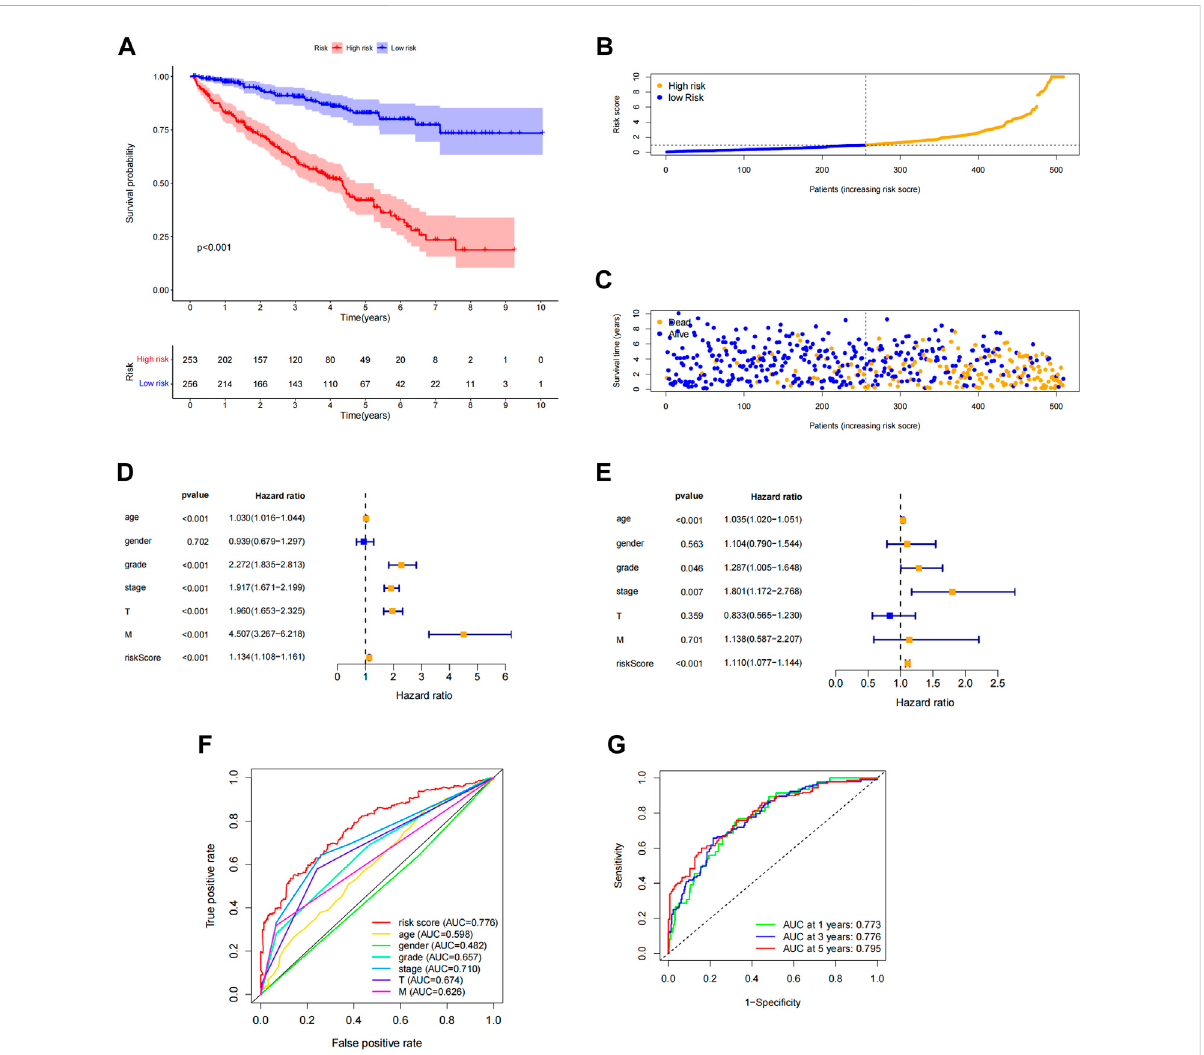
FIGURE 4 Association of predictive features with prognosis in ccRCC patients. (A) Kaplan-Meier analysis of OS rates in the high- and low-risk groups of ccRCC patients. (B) Distribution of risk scores in ccRCC patients. (C) Number of deaths and surviving patients with different risk scores. Blue blot indicatesthenumberofsurvivorsandyellowblotindicatesthenumberofdeaths. (D) ForestplotofunivariateCoxregressionanalysis. (E) Multivariate Cox regression analysis forest plot. (F) ROC curve of risk score and clinicopathological variables. (G) ROC curve and AUCs of predictive characteristics of 1-year, 3-year and 5-year survival rates. ccRCC, renal clear cell carcinoma; OS, survival rate; ROC, receiver operating characteristics; AUC, area under the curve; T,